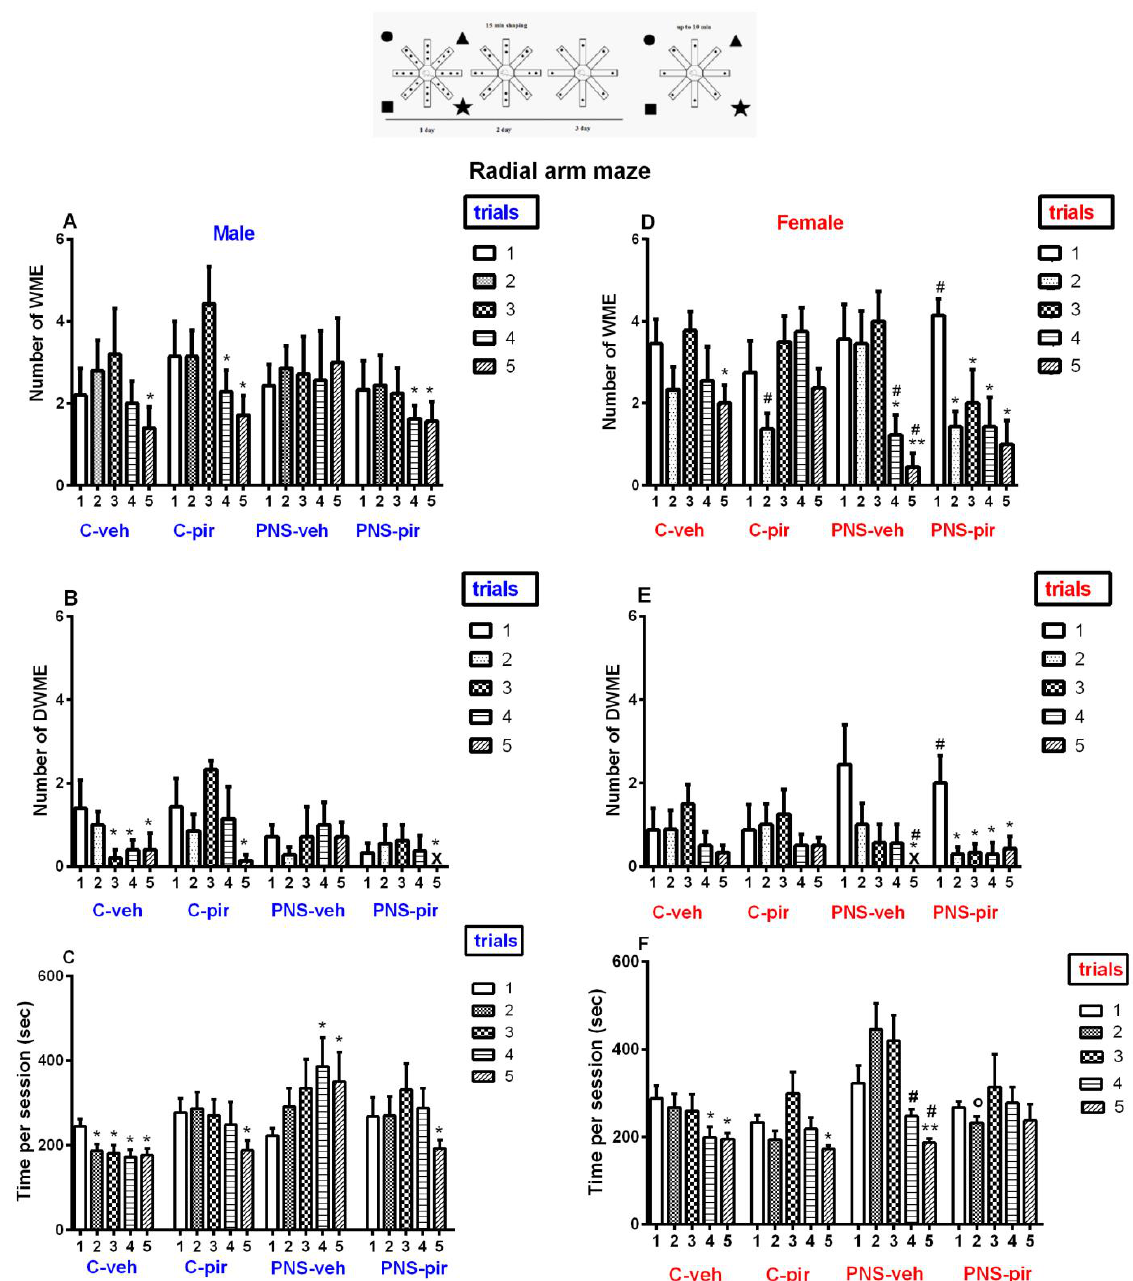
Figure 2. The chronic Piromelatine treatment exerted a beneficial effect on cognitive impairment of offspring with a history of prenatal stress in RAM test. Three-way ANOVA indicated a main treatment effect [F 3,296 = 2.672, p = 0.047], a main trial effect [F 4,296 = 6.370, p < 0.001] and interaction between treatment × sex × trial [F12,296 = 2.98, p = 0.05] on the number of WMEs ( A , D ), a main trial effect [F 4,296 = 5.596, p < 0.001] and interaction between treatment × sex × trial [F 12,296 = 1.917, p = 0.033] on the number of DWMEs ( B , E ), a main treatment effect [F 3,296 = 15.100, p < 0.001], a main trial effect [F 3,296 = 5.594, p < 0.001] and interaction between treatment × sex × trial [F 12,296 = 2.559, p = 0.003] on time per session ( C , F ). Data are presented as means ± SEM. * p < 0.05 vs. first session, o p < 0.05 vs. PNS-veh, # p < 0.05 vs.